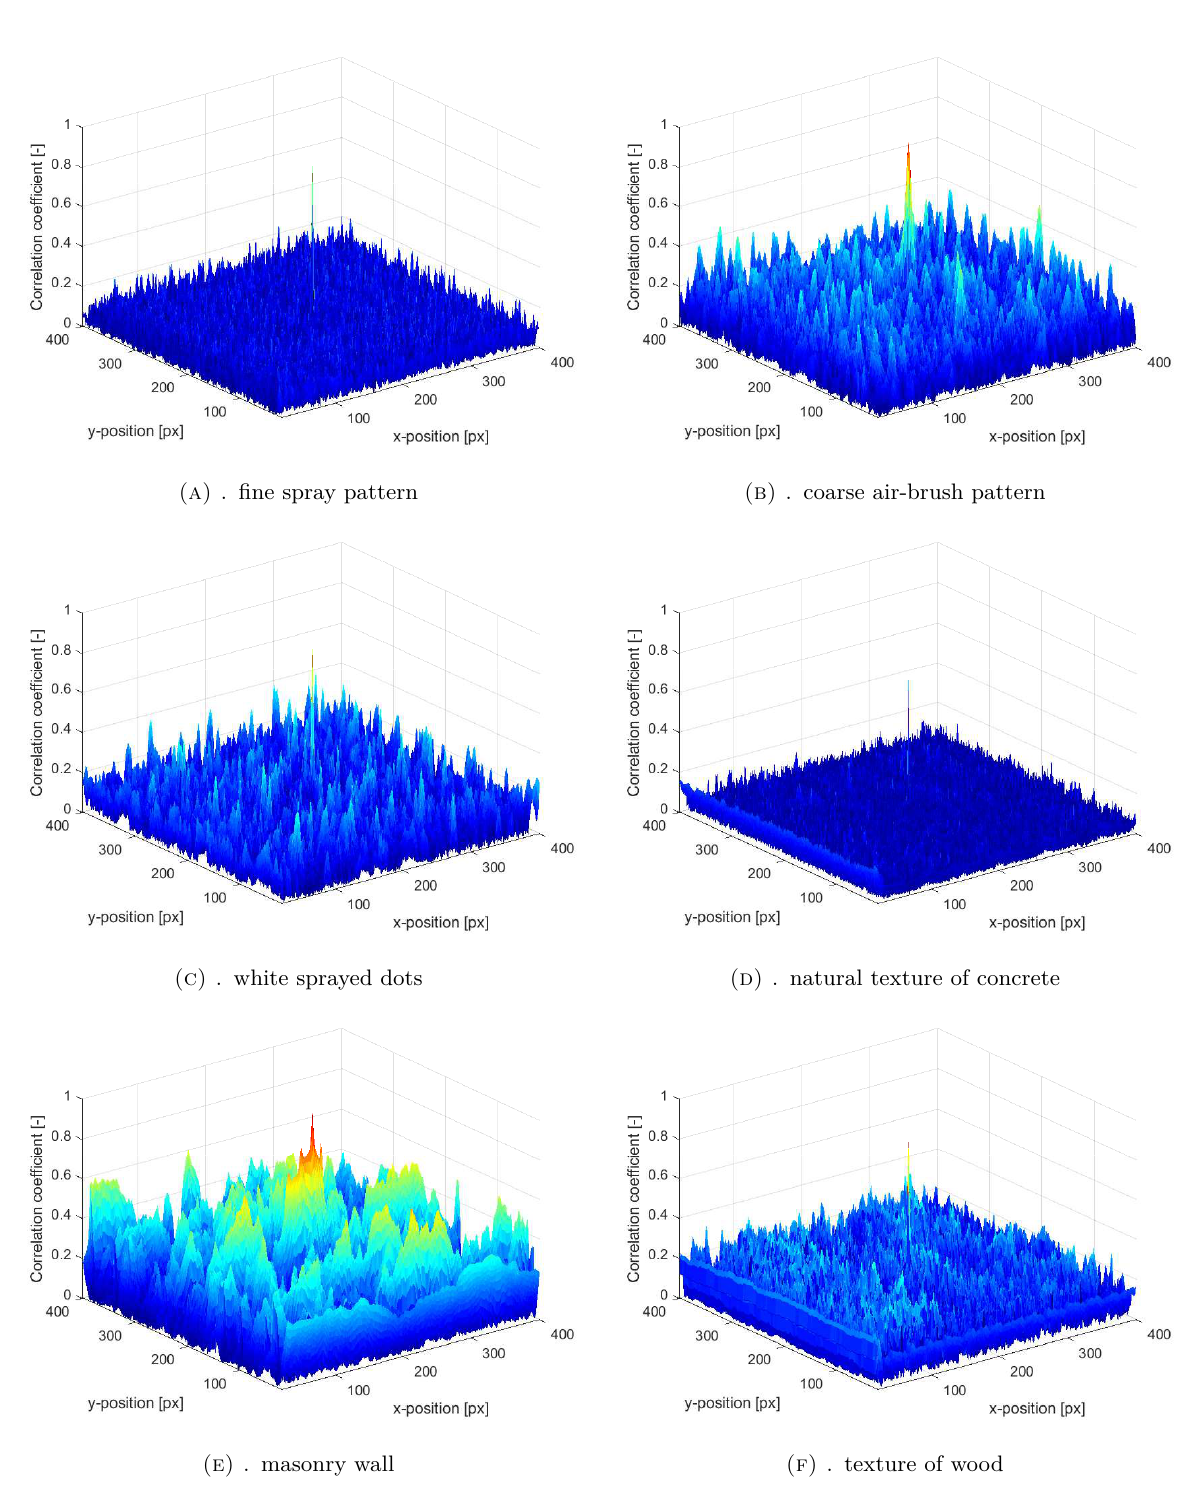
Figure 4. Correlation function values for 30 × 30 px subset